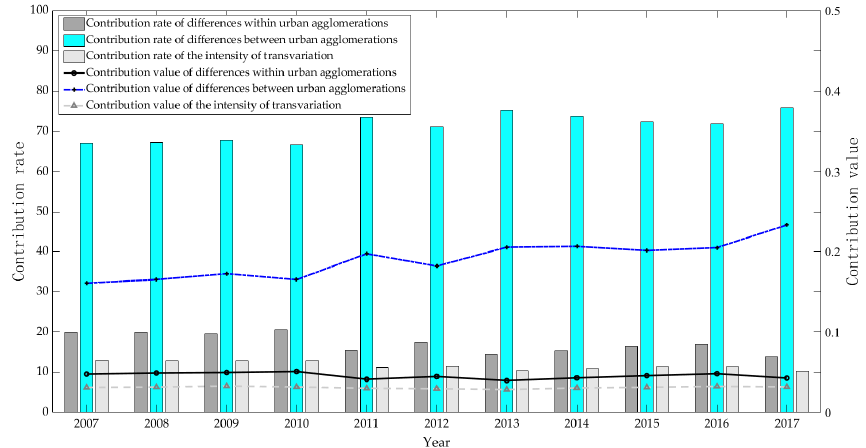
Figure 8. Evolution of contribution to CEI’s differences of urban agglomerations in the YRB from 2007 to 2017.